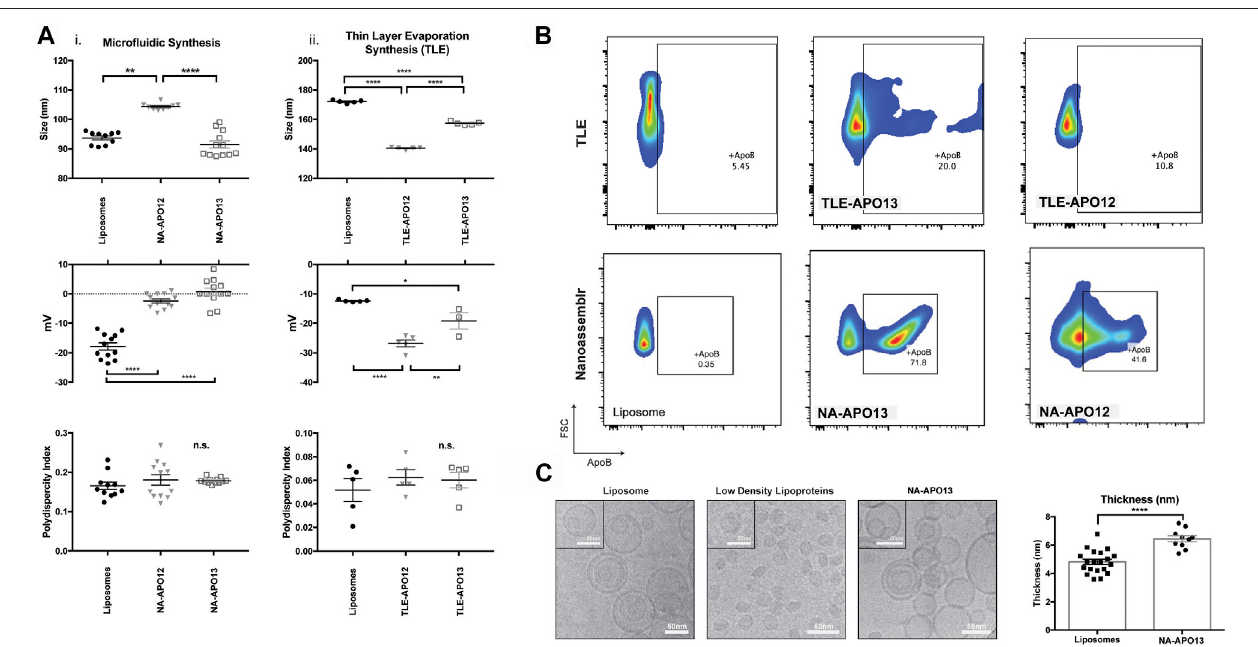
FIGURE1| Aposomenanoparticlesmadeusingnano fl uidicsynthesismethodshowhigher apoB-100 enrichment ofnanoparticles compared toTLEmethod – (A) Size, polydispersity index and surface charge for nanoparticles (NPs) made using a nano fl uidic method and thin layer evaporation using two different protein sources for LDL derived from two different plasma fractions (B) Flow cytometry analysis of surface apoB-100 show that NPs made using a micro fl uidic method show higher LDL enrichment than similar particles synthesized using thin layer evaporation, based on these results it was determined that particles made with FPLC fraction 13 and using a micro fl uidic method was most effective for LDL enrichment. From this point onward Aposome refers to these particles unless speci fi ed otherwise (C) Cryo-TEM imaging of liposomes and Aposomes, Aposomes show increased membrane thickness of the lipid bilayer assessed using Fiji software.